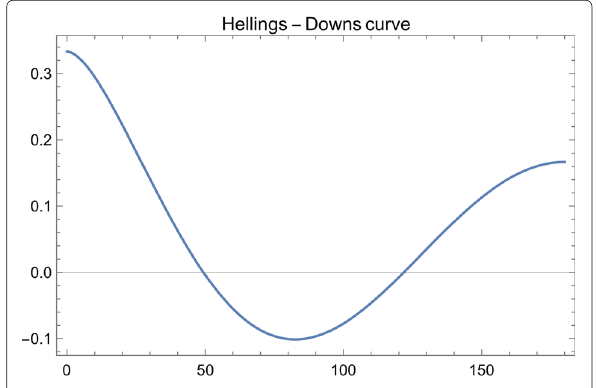
Fig. 2 Hellings-Downs curve C (θ ab ) as a function of θ ab